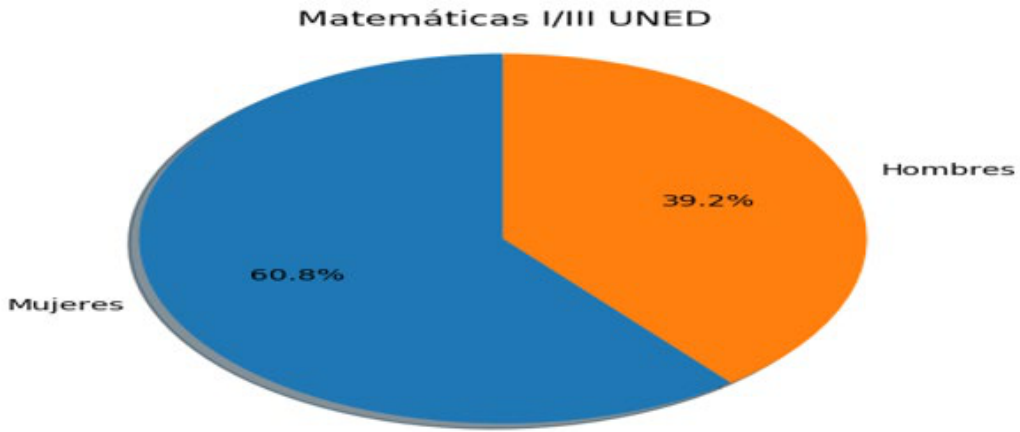
Figure 5. Female students vs. male studenst in both of